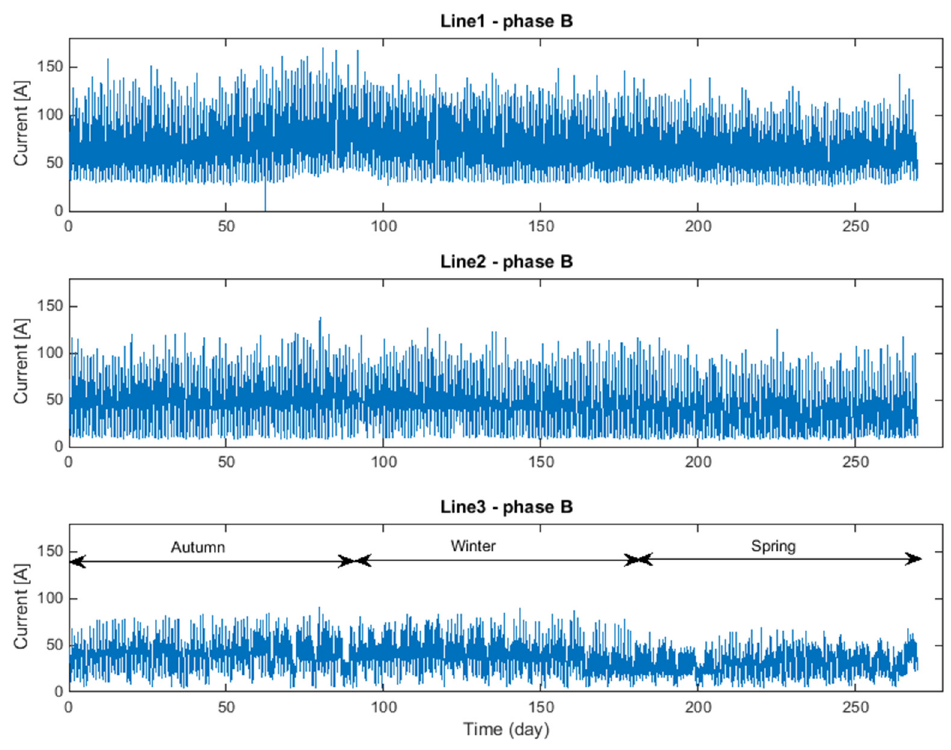
Figure 3. Time-domain waveforms of the currents flowing into the phase B of the three distribution circuits L1, L2, L3, for the whole analysis period. Table 1. Characteristics of the PDS under investigation.